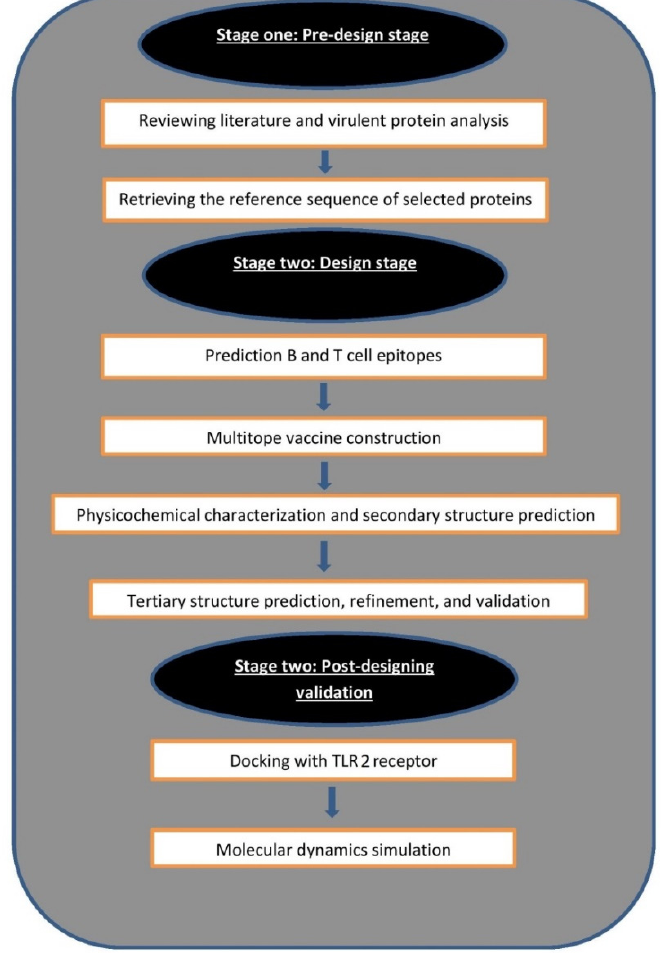
Figure 1. Graphical representation shows the major steps for constructing a multitope vaccine against